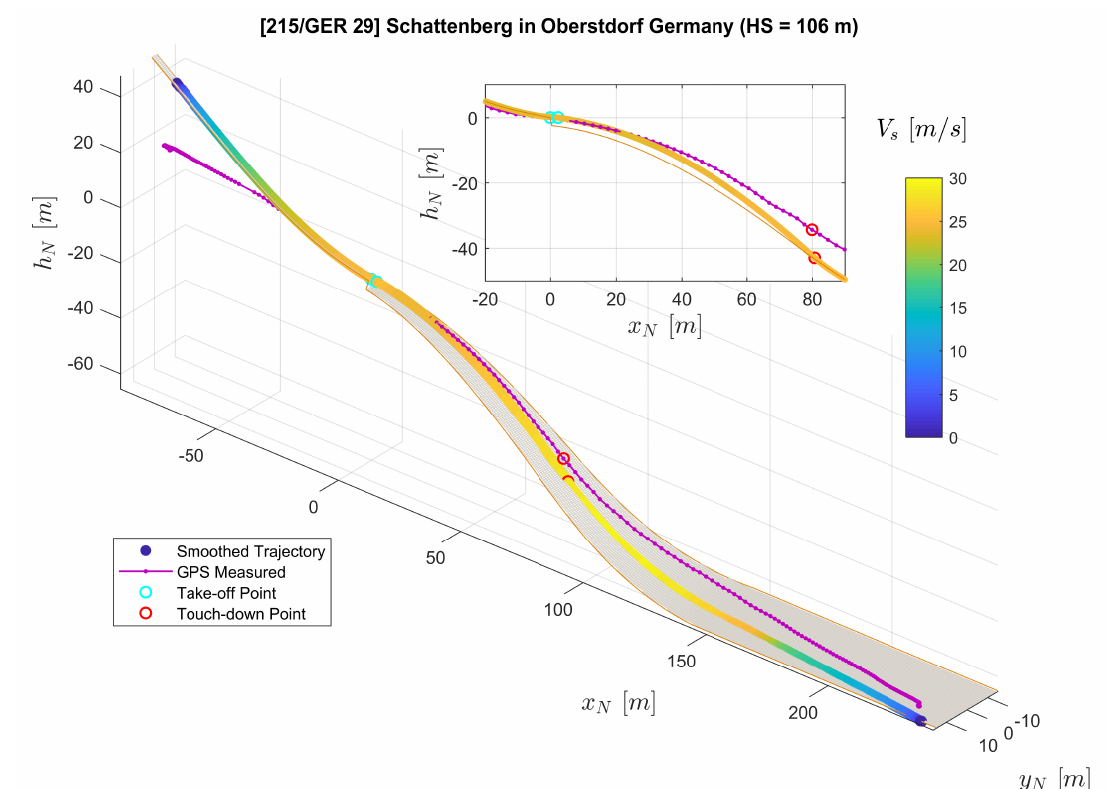
Figure 7. Comparison of the extended RTS smoother reconstructed trajectory (color-coded line) and the GPS measured trajectory (purple solid line with dots) plotted on the ski jumping hill model (orange lines and the gray surface).